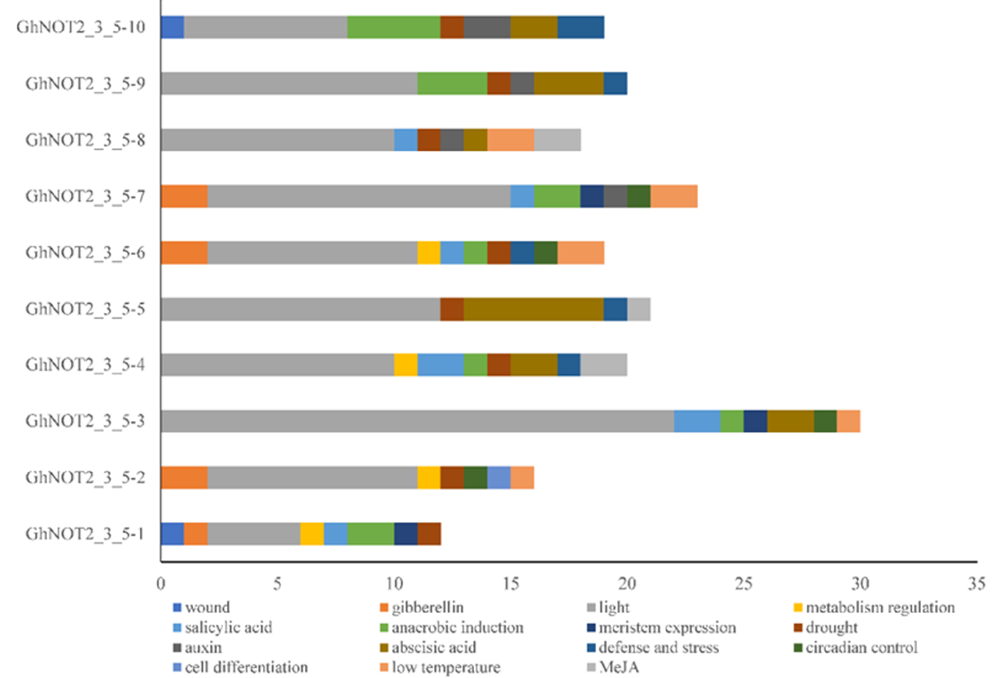
Figure 4. Cis -Regulatory elements analysis of NOT 2_3_5 promoter regions. Different colors represented different cis -regulatory elements and numbers in abscissa were the numbers of cis -regulatory element.